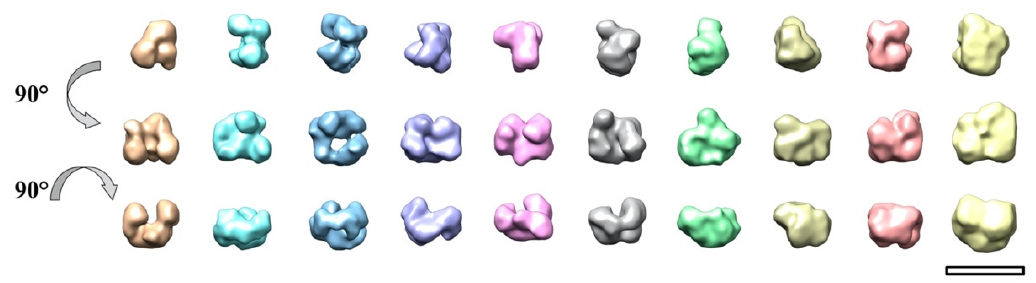
Figure A5. Various projections of iron clusters with a volume in the range 10–30 nm 3 at a threshold of 3 σ divided into 10 3D classes. The classes are arranged in ascending volume (left to right). Scale bar is 5 nm.